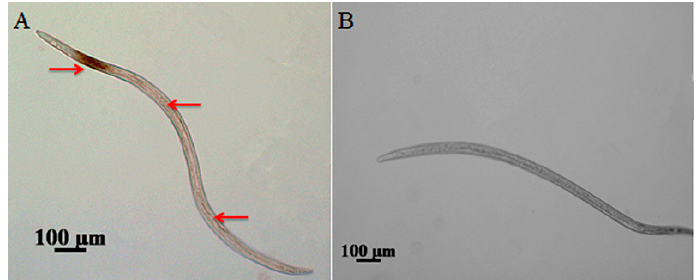
Figure 3. Localization of Bx-ATG8 mRNA by in situ hybridization (ISH) using a digoxigenin (DIG)-labeled BxATG8 antisense or sense probe. The hybridization sites are shown in B. xylophilus ( A ), including the oesophageal gland cells (right arrows), and lateral hypodermal seam cells (left arrows). Control sense probe in B. xylophilus ( B ). The scale bars = 100 µm.